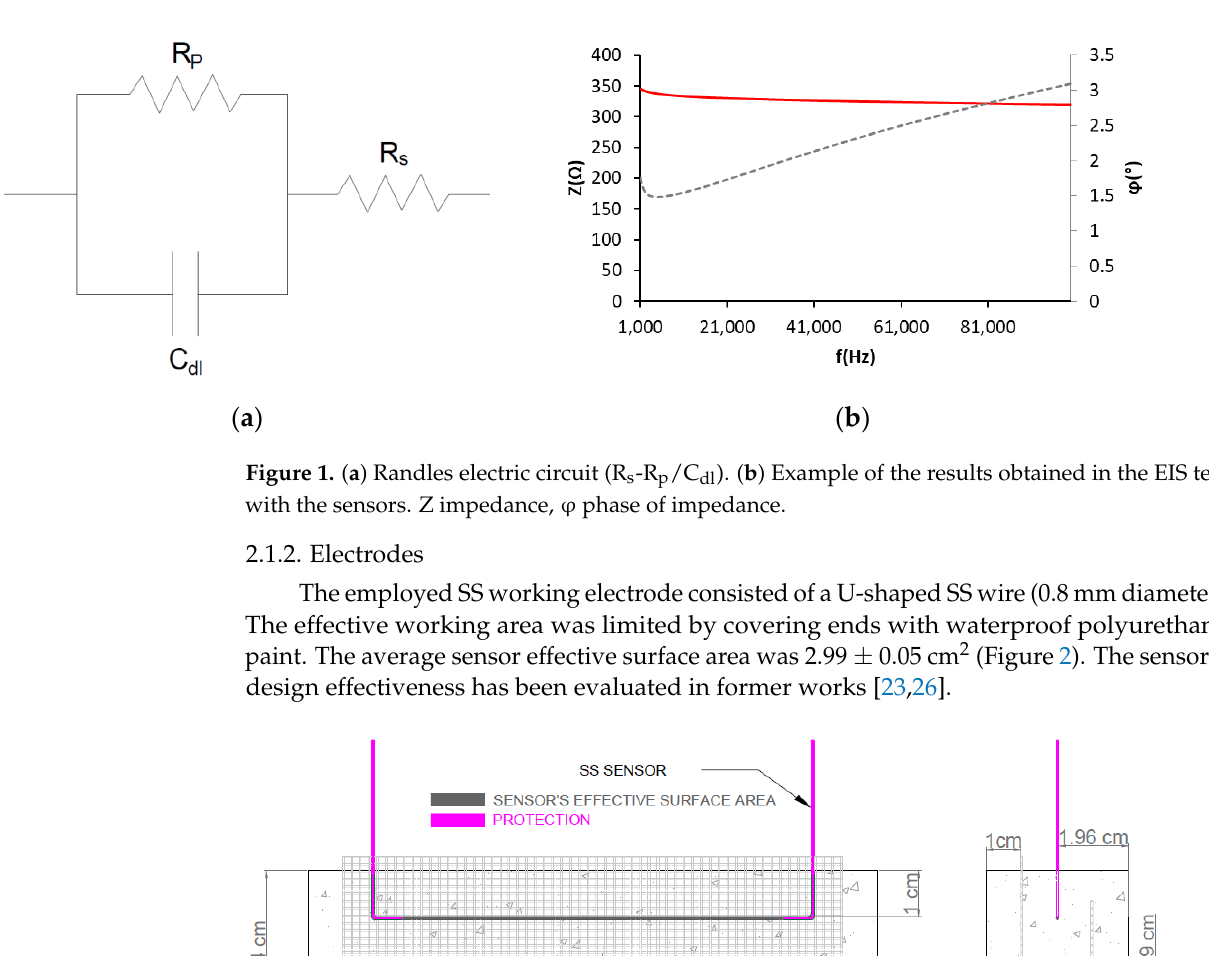
Figure 1. ( a ) Randles electric circuit (R s -R p /C dl ). ( b ) Example of the results obtained in the EIS test with the sensors. Z impedance, φ phase of impedance.